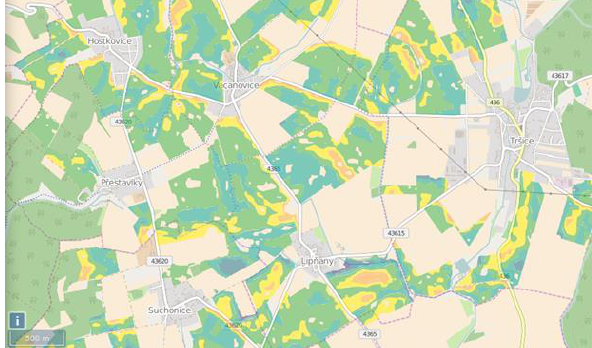
Figure 4. Demonstration of the yield potential zones in the Tršická zemědělská farm (the Czech Republic). Orange and yellow areas depicts zones with high yield potential, medium green with average and dark green zones with low yield